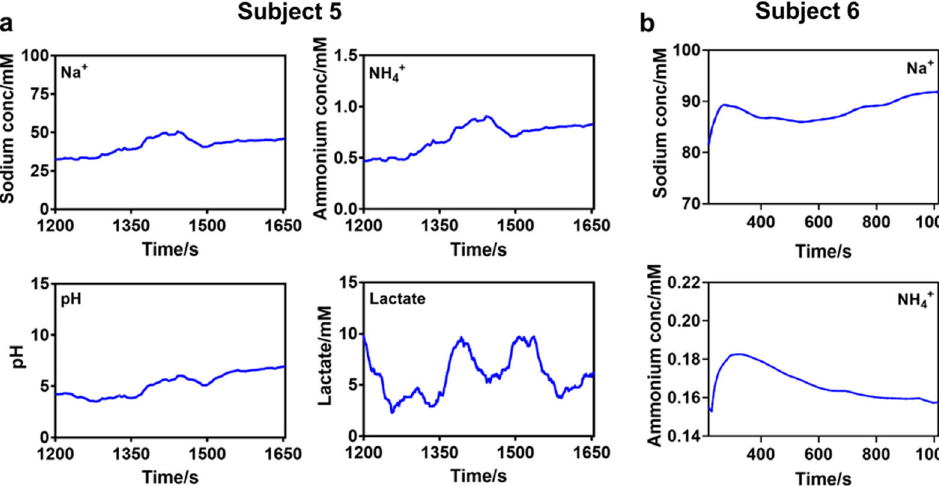
Fig. 8 Simultaneous and real-time multiplexed sweat patch sensor data using wearable readout electronics. a Sensor data of ammonium, sodium, pH, and lactate of Subject 5 wearing the sweat sensor patch on the forehead during the stationary cycling. b Sensor data of Subject 6 wearing a waist belt integrated with sensor patch and the electronic during treadmill run.